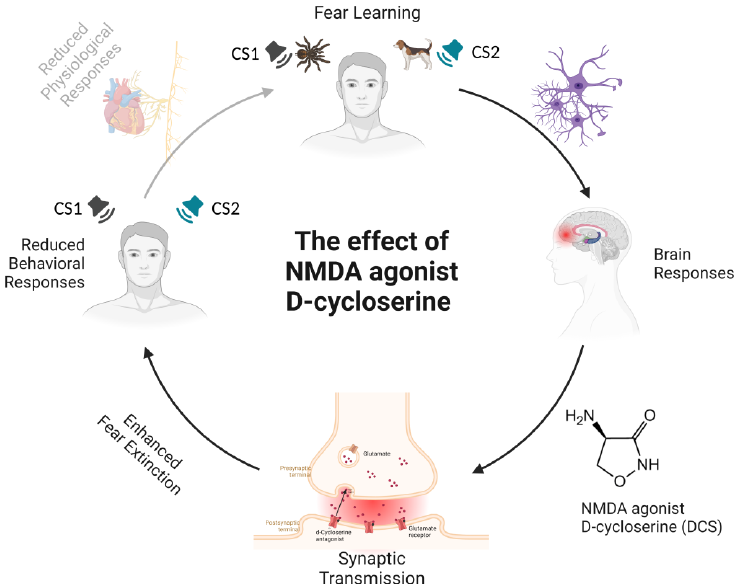
Figure 1. Schematic representation of the amelioration of N-methyl-D-aspartate (NMDA) recep- tor activity-related effects by the administration of agonist D-cycloserine (DCS) during fear ex- tinction. During a fear-learning paradigm, a previously neutral stimulus (the conditioned stimulus) acquires emotional significance through pairing with an aversive stimulus. The aversive stimulus elicits a range of automatic, unconditioned fear responses, such as freezing and increased heart rate or blood pressure. After a few pairings, the presentation of the conditioned stimulus alone is capable of eliciting a conditioned fear response. The neural networks underlying fear learning mainly in- clude the amygdala, prefrontal cortex, and hippocampus. Connections between these cortical and subcortical brain regions regulate the acquisition and extinction of fear. The activation of NMDA receptors—ionotropic channels that allow calcium ions into the cell—is necessary for long-term po- tentiation processes underlying fear learning. DCS, an NMDA partial antagonist, binds to one of the subunits of the NMDA receptor complex and changes its shape. The result is that glutamate opens up the channel and lets more calcium in, leading to boosted excitation by raising the glutamate levels in the interneurons. The specific effects of DCS in humans include enhanced fear extinction memory retention, expressed as attenuated conditioned responses during extinction recall on sub- jective (i.e., valence and arousal ratings) and physiological (SCR, BOLD response) levels. Notes. CS1 = Conditioned Stimulus 1; CS2 = Conditioned Stimulus 2; DCS = D-cycloserine; NMDA = N-methyl- D-aspartate. Indeed, such studies have highlighted the mechanisms of human fear extinction pro- moted by DCS, considering the dosages and timing of administration, thus confirming the